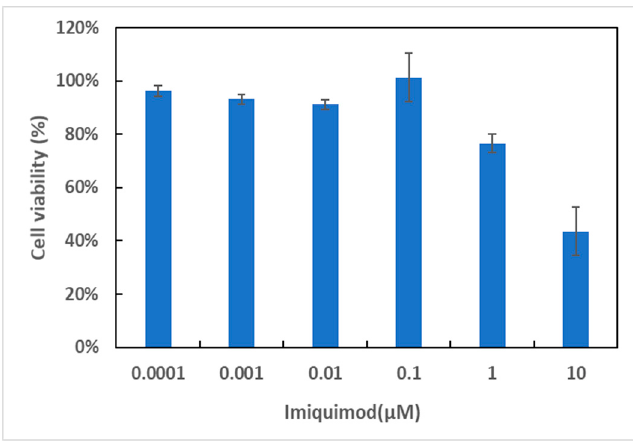
Figure 4. 4T1 cytotoxicity at 24 h in the presence of IMQ-containing liposomes.